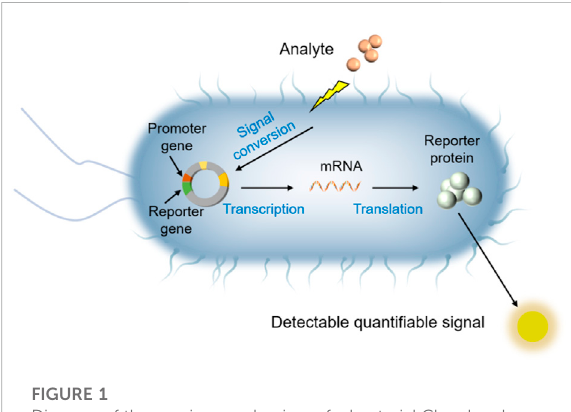
FIGURE 1 Diagram of the sensing mechanism of a bacterial Class I and Class II whole-cell